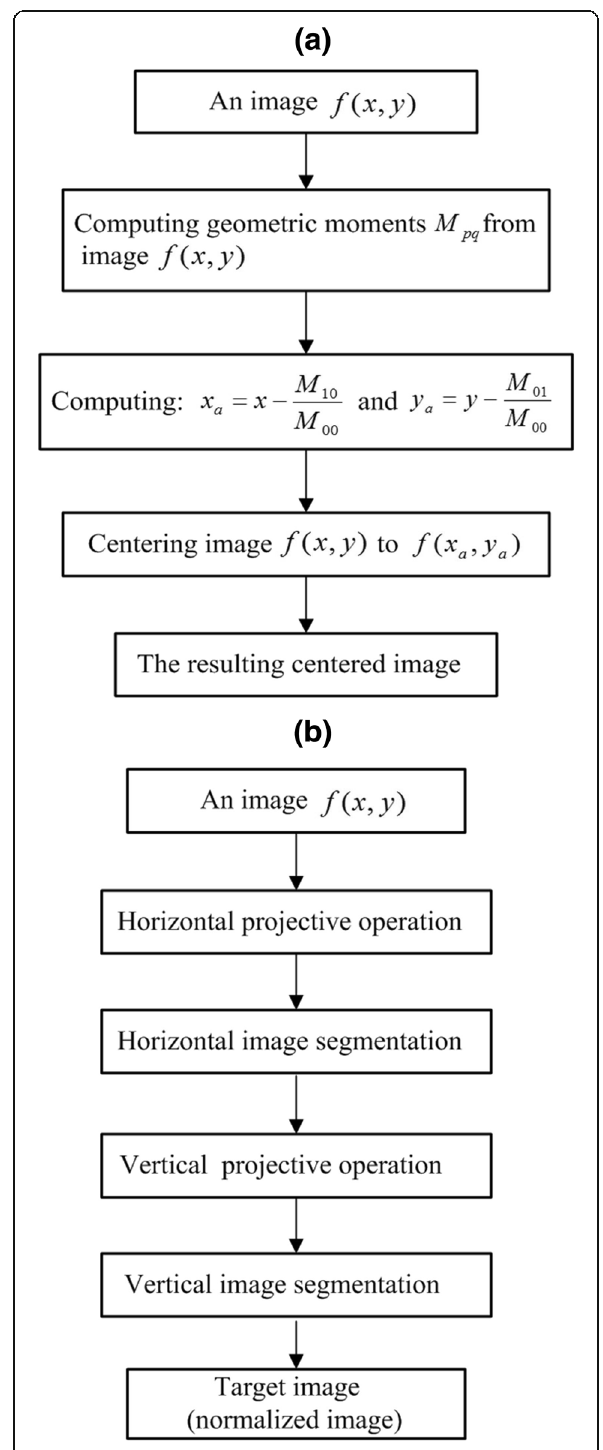
Fig. 14 a The block diagram of traditional translation invariant algorithm. b The block diagram of our